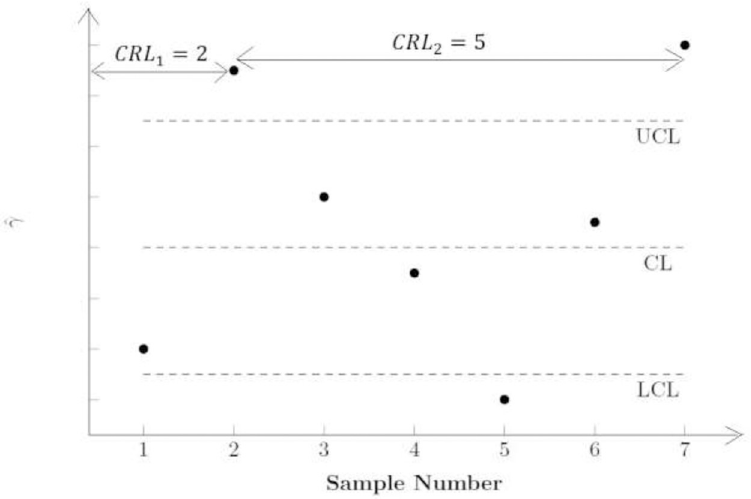
Fig 2. The CRL sub–chart of the Side–sensitive Synthetic– γ (SS) chart. The proposed multivariate SS chart monitors ^ g 2 , instead of ^ g , due to the availability of the mean and standard deviation of ^ g 2 from Giner-Bosch et al. [22]. The following are the LCL and UCL of the proposed multivariate SS chart